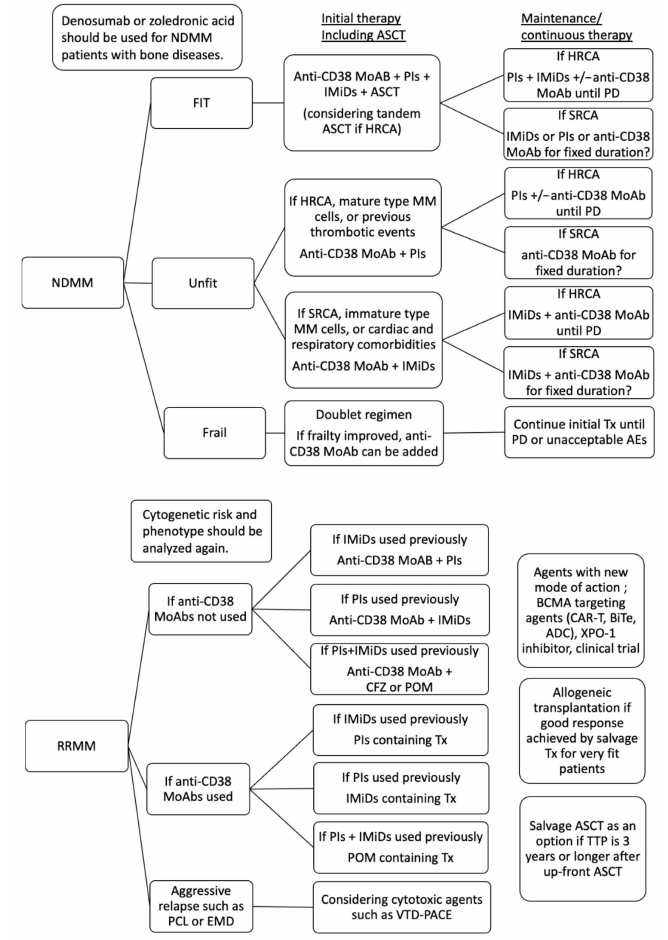
Figure 3. Treatment strategies for fit and unfit patients with NDMM, and RRMM, terminal phase MM. Multi-drug treatment including PIs, IMiDs, CD38 MoAb, and ASCT is essential for fit patients with NDMM. For unfit patients, who are